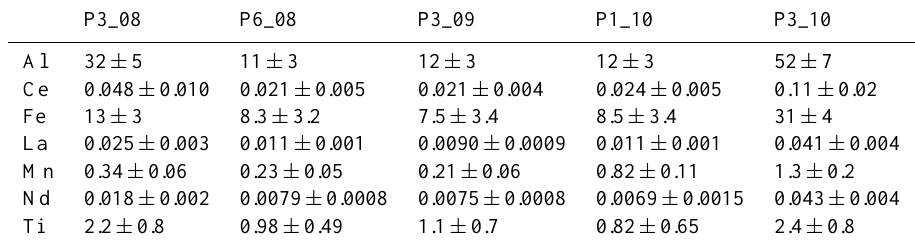
Table 3a. Rain event fluxes (µgm − 2 ) ± uncertainties, deduced from measurements of the non-contaminated samples.